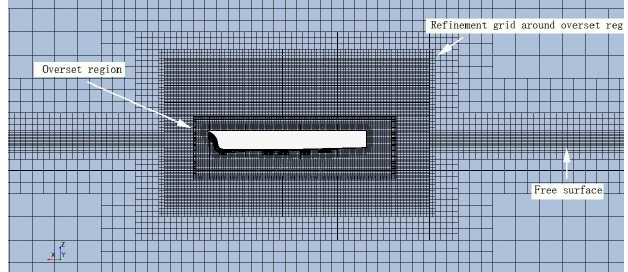
Figure 7 . Refinement of grids.